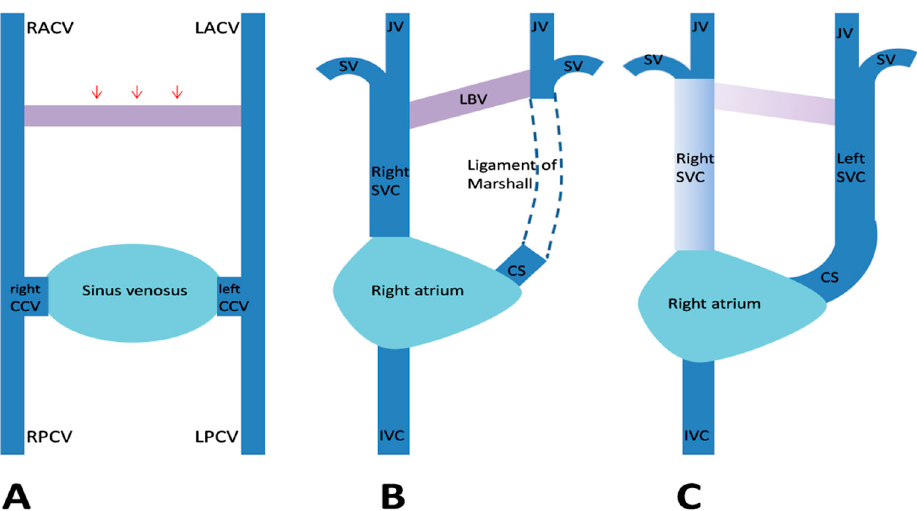
Figure 3. Embryological development of a persistent left superior vena cava (SVC). ( A ) The venous drainage system of the embryo, with transverse anastomosis (red arrows) forming between the anterior cardinal veins. ( B ) Normal regression of the proximal segment of the left anterior cardinal vein (LACV) and the formation of the ligament of Marshall. ( C ) When this obliteration fails to occur, a left SVC develops. Abbreviations: CCV, common cardinal vein; CS, coronary sinus; IVC, inferior vena cava; JV, internal jugular vein; LBV, left brachiocephalic vein; LPCV, left posterior cardinal vein; RACV, right anterior cardinal vein; RPCV, right posterior cardinal vein; and SV, subclavian vein (Figure modified from Figure 5 in [17]).